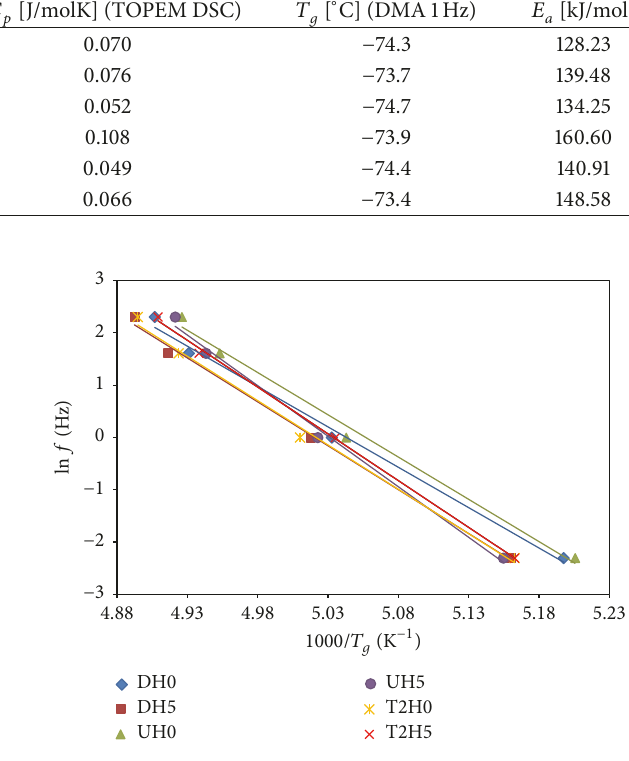
Figure 3: Arrhenius frequency map of POM and POM/HAp nanocomposites calculated from DMA results. DMA points corre- spond to the 𝛾 peak at tan 𝛿 .